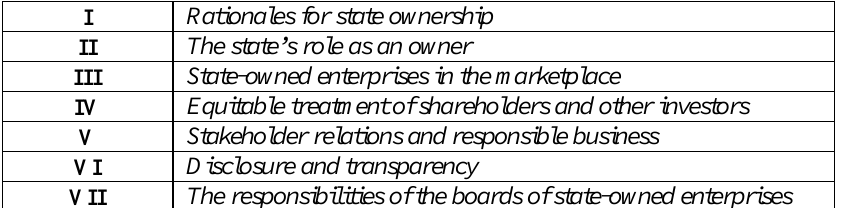
Table 1: Seven Principles of Corporate Governance of SOEs